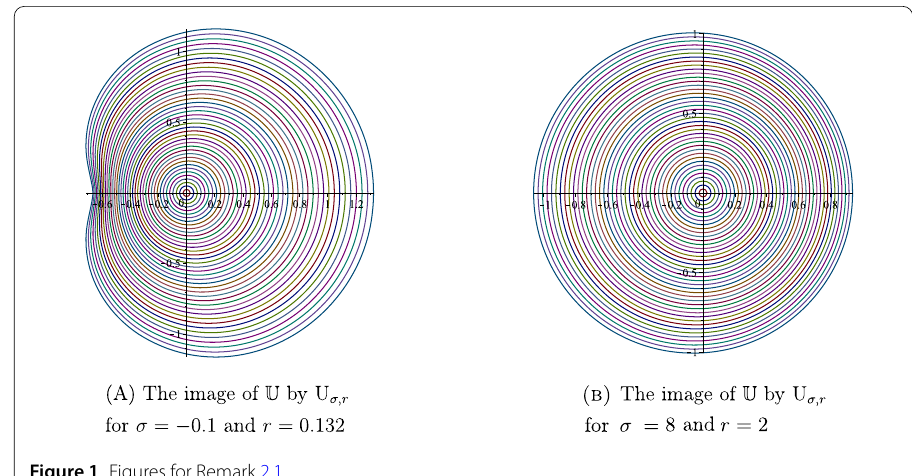
Figure 1 Figures for Remark